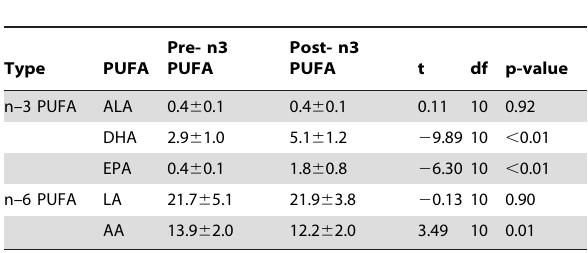
Table 1. RBC fatty acid composition analysis.